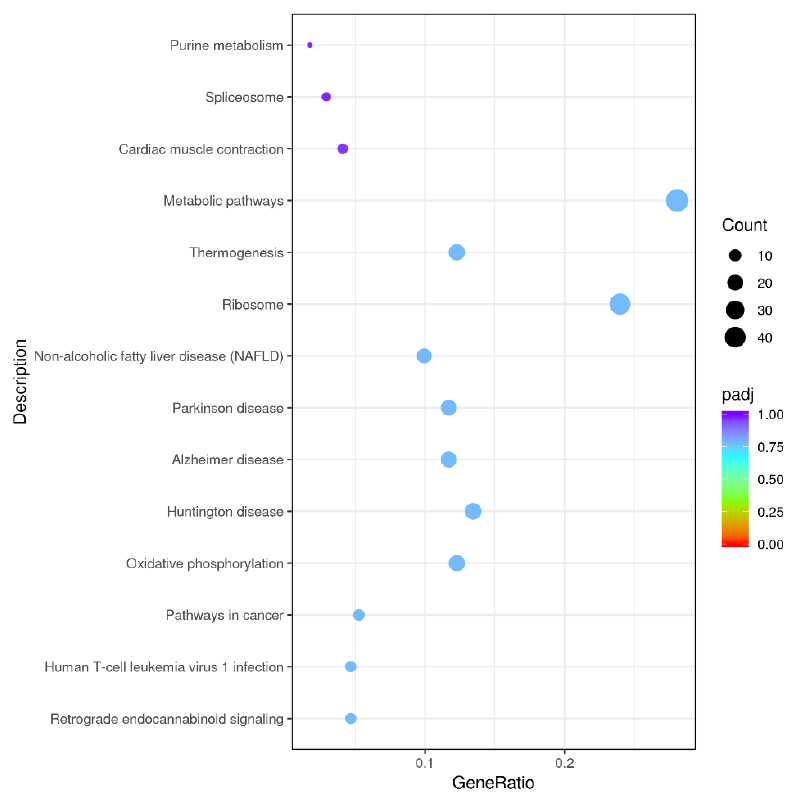
Figure 4. Kyoto Encyclopedia of Genes and Genomes (KEGG) functional annotations of DEGs. Enrichment of DEGs in different signal pathways. X axis represents GeneRatio, which contains amount of DEGs enriched in pathway; Y axis represents pathway ( P adjusted < 0.05).